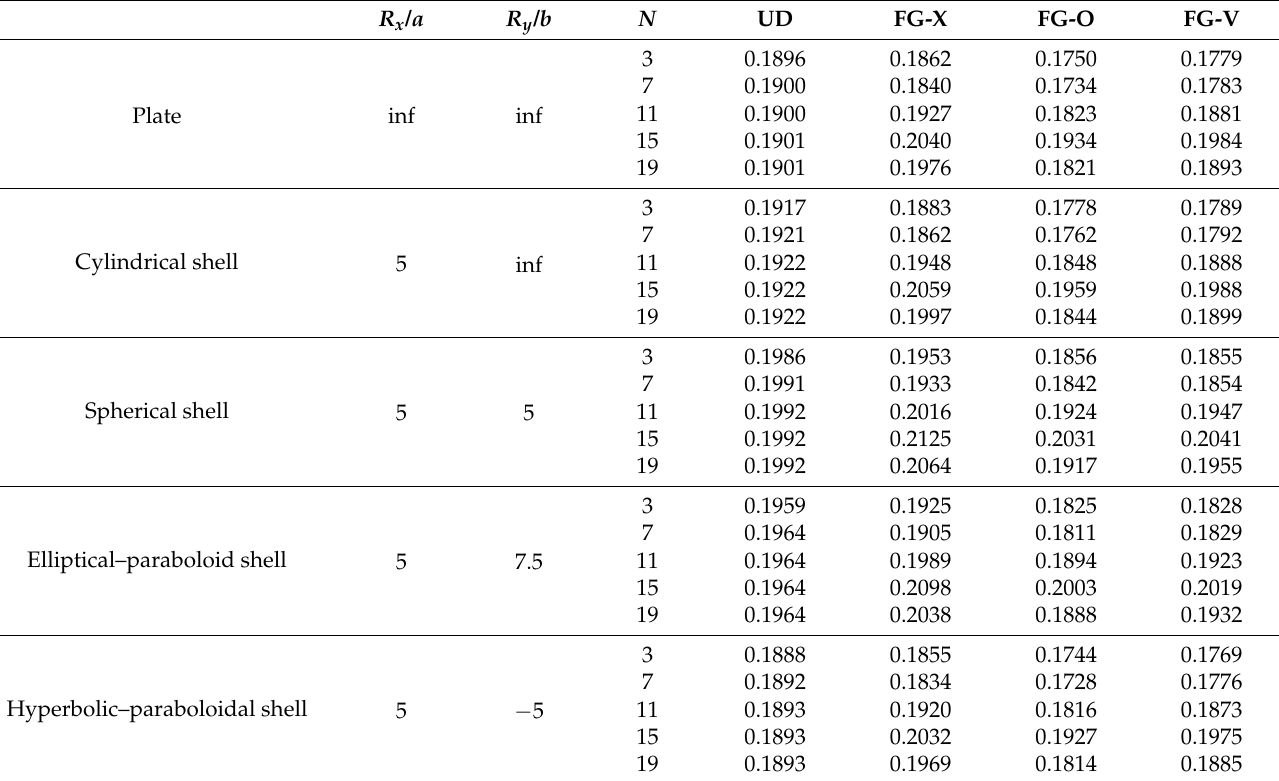
Table 5. The effect of the number of layers and fiber distribution patterns on the dimensionless frequency of cross-ply CNTs/F-RC shells for various curvature radii (SSSS, b / a = 1, a / h =